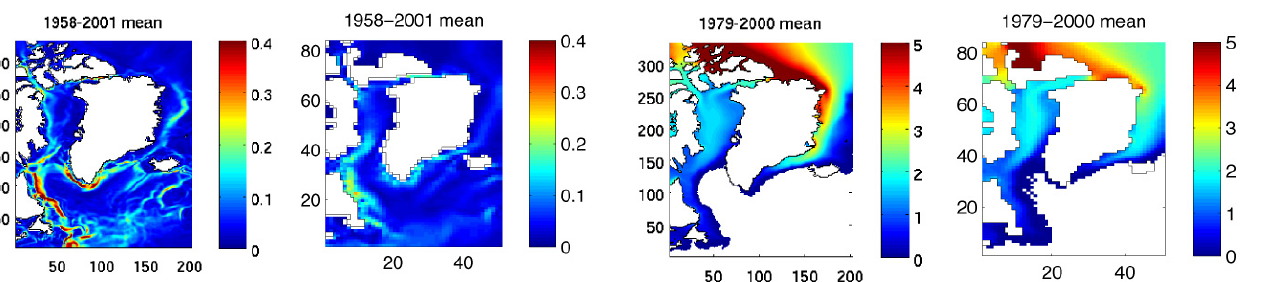
Fig. 2. March sea ice thickness (m) averaged over 1979–2000 in control experiments with NEMO at resolutions of 0.25 ◦ and 1 ◦ (left and right panels